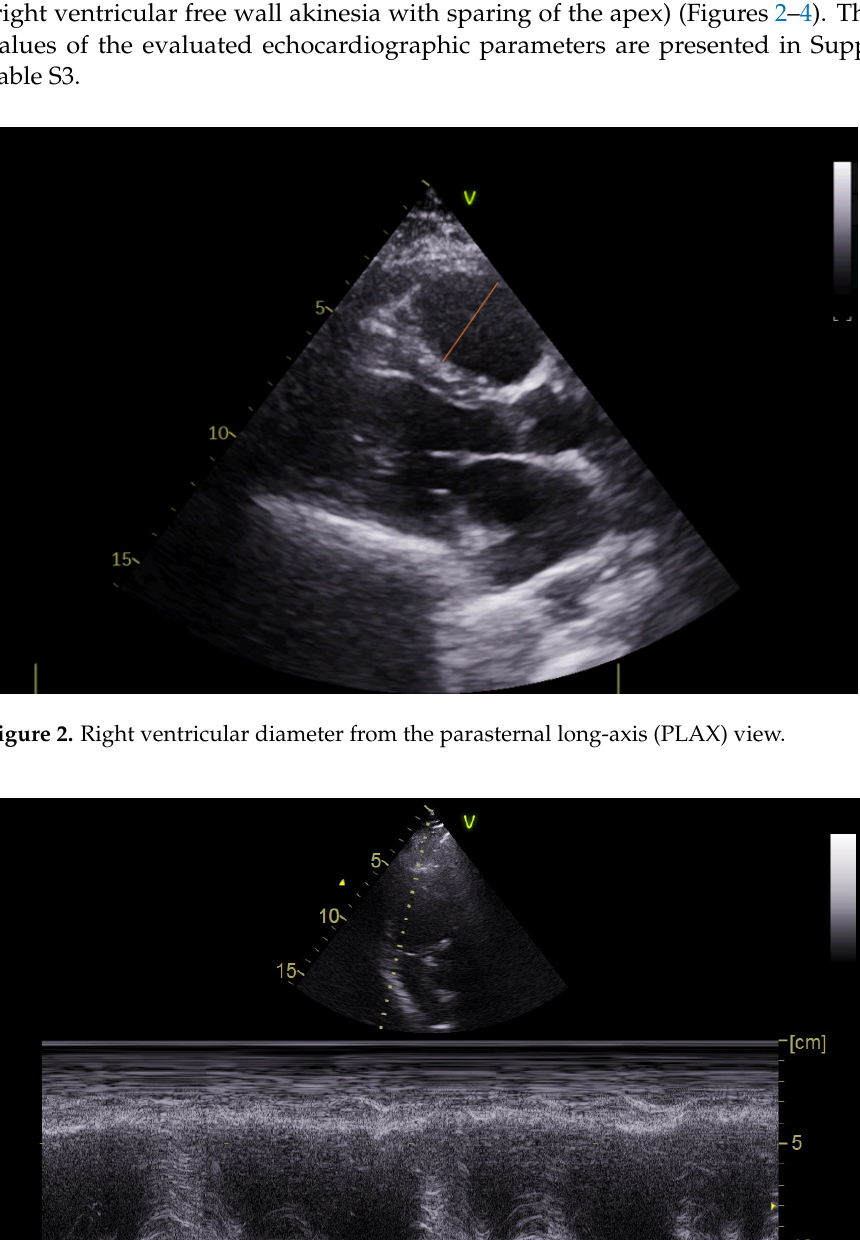
Figure 4. Continuous-Wave (CW) Doppler of tricuspid regurgitation from the 4-chamber view. 2.5. Statistical Analysis Numerical data are presented as means with standard deviations or medians with percentiles. Categorical variables are summarized by absolute numbers with percentages. Differences in the need for oxygen support and patients’ clinical, laboratory, and point- of-care echocardiographic parameters were analyzed using the Chi-Square test, Students’ test for independent samples, or the Mann–Whitney U test. Correlations between the PESI score and patients’ clinical, laboratory, and echocardiographic parameters were assessed by the Spearman correlation coefficient. Univariate and multivariate logistic regression models were used to assess the predictors of the need for oxygen support (as a dependent